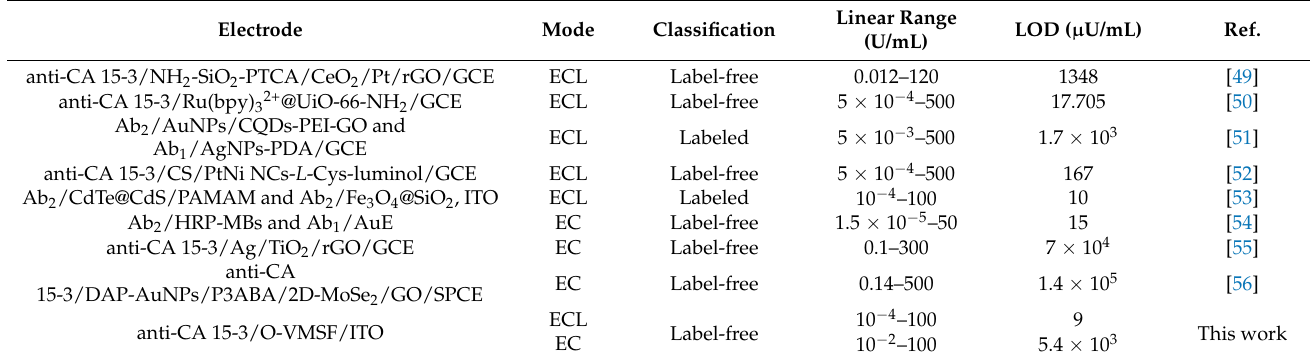
Figure 5. ( a ) DPV curves of VMSF/ITO, O-VMSF/ITO, anti-CA 15-3/O-VMSF/ITO, and CA 15-3/anti-CA 15-3/O-VMSF/ITO in 10 μ M Ru(bpy) 32+ . ( b ) DPV response of anti-CA 15-3/O-VMSF/ITO in the presence of different concentrations of CA 15-3. ( c ) The corresponding calibration curve. The error bars represent the standard deviation of three measurements under the same condition. Table 1. Comparison of various methods for the determination of CA 15-3.